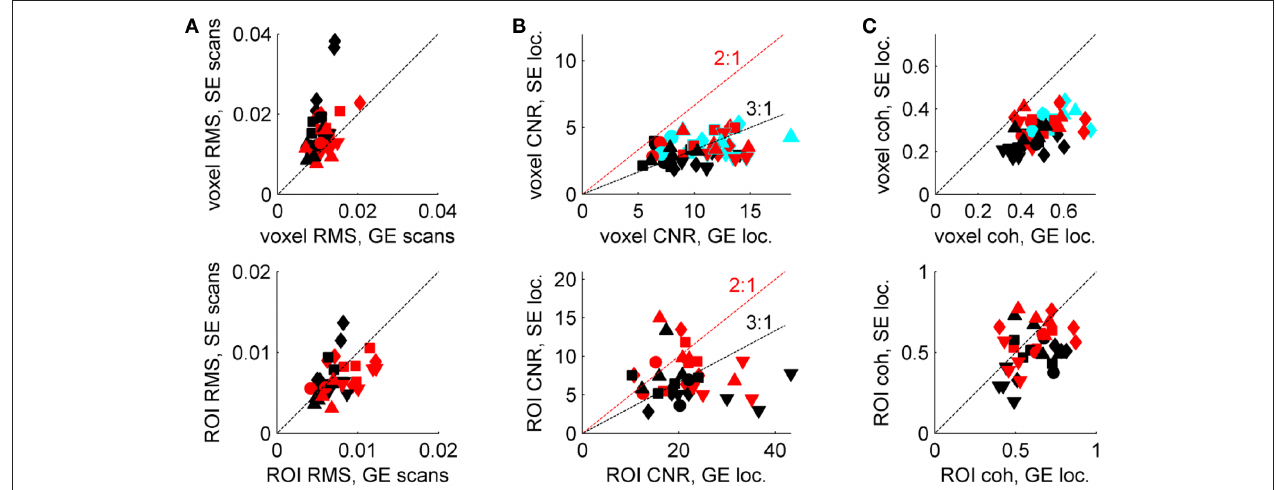
each ROI were averaged before calculating RMS. (B) Top panel: average CNR in GE (abscissa) and SE (ordinate) block-design localizer scans for SE ROIs (red), GE ROIs (black) and voxels included in both types of ROIs (cyan). Bottom panel: CNR calculated after averaging all voxels in an ROI. (C) Average voxel coherence (top panel) and ROI coherence in each type of ROI (bottom panel); colors as in